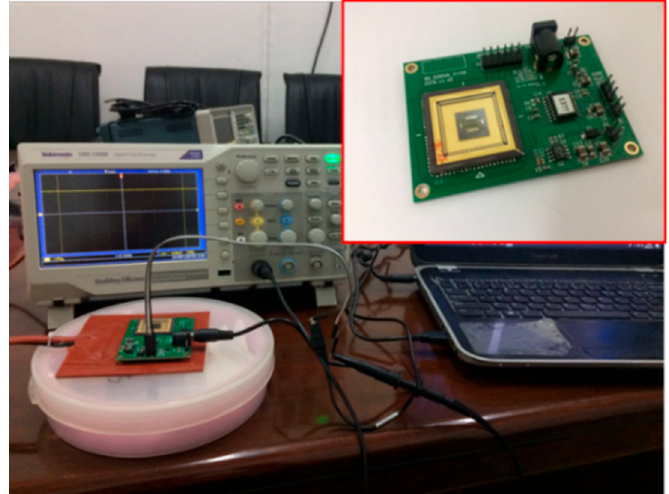
Figure 17. Packaged chip and circuit. Sensors 2018 , 18 , x FOR PEER REVIEW